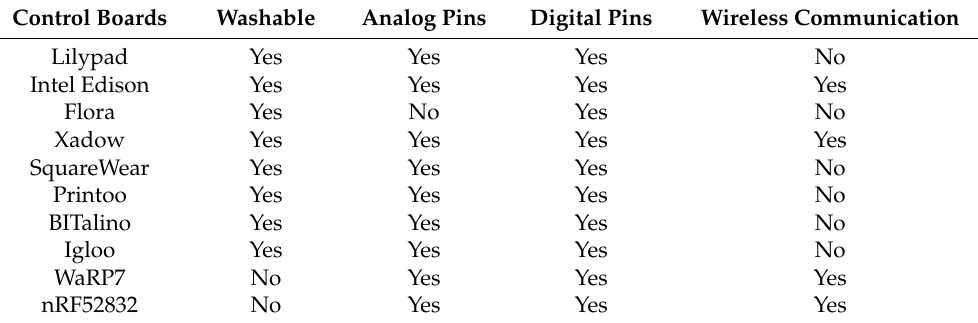
Table 2. Atribute comparisson of wearable control boards